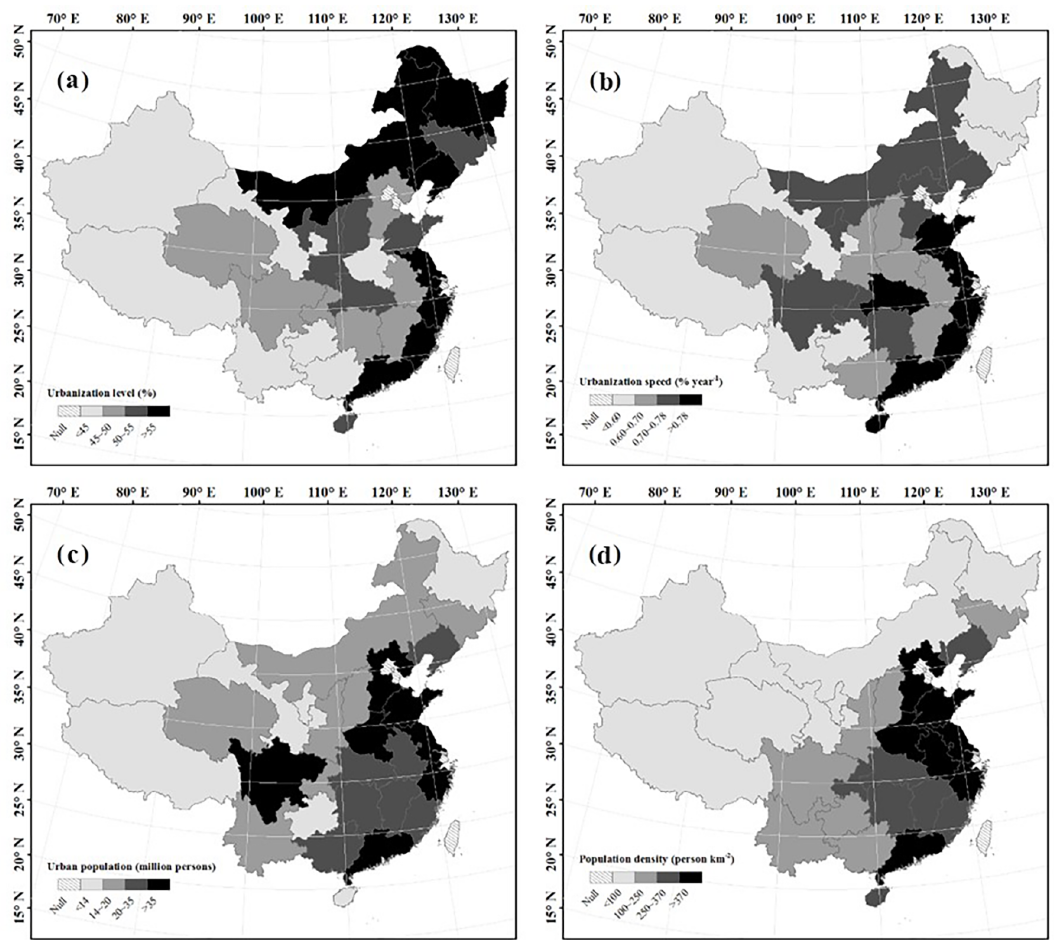
Figure 6. Spatial comparisons of urbanization level ( a ; %), urbanization speed ( b ; %yr − 1 ), urban population ( c ; millionpersons), and population density ( d ; personkm − 2 ) for the 28 provincial-level divisions across China. Urbanization level, urban population, and population density are calculated with respect to the year 2013. Urbanization speed is calculated for the period 1960–2013. The cutoff points are chosen based on the quantile